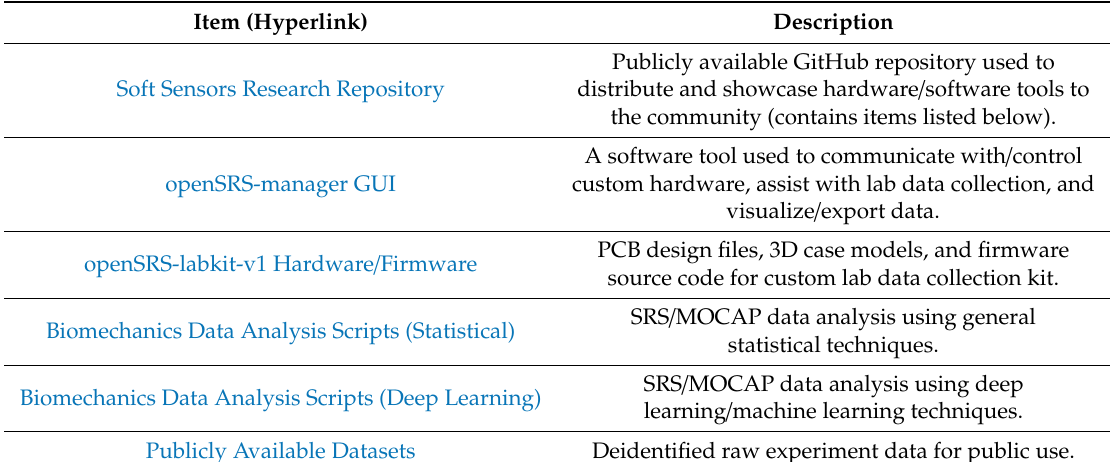
Table 1. GitHub location of all SSTK solutions developed as part of the Closing the Wearable Gap paper